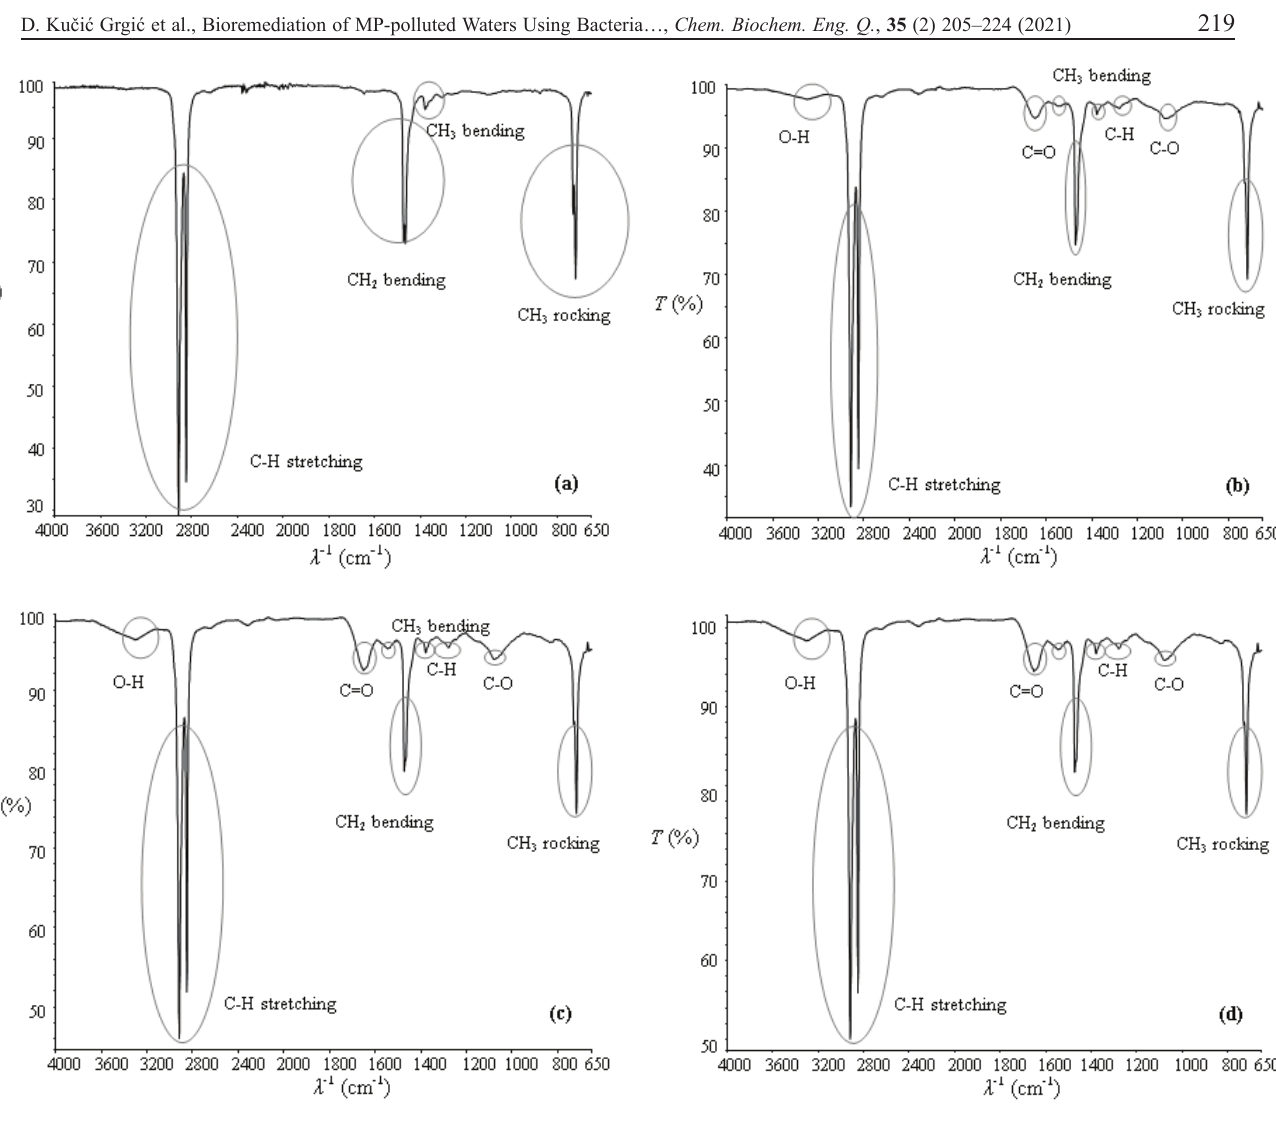
Fig. 10 – FTIR-ATR spectrum before (a), and after biodegradation of MP-LDPE with bacterial culture Bacillus licheniformis (b), Lysinibacillus massiliensis (c), and mixed bacterial culture of Bacillus sp. and Delftia acidovorans